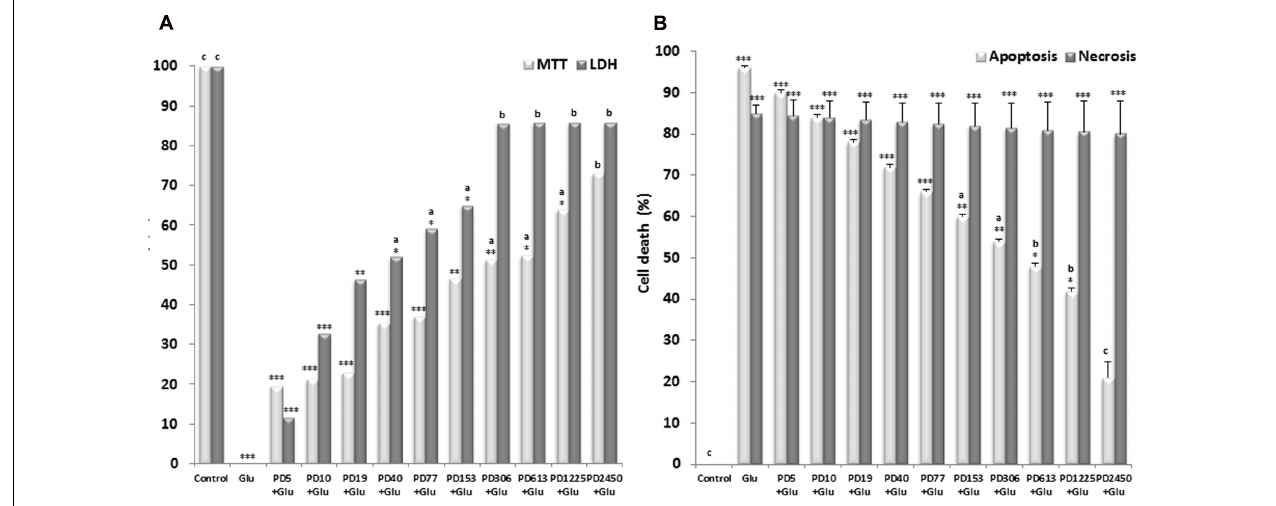
FIGURE 5 | Effects of P. daemia against L -glutamate-induced neurotoxicity, apoptosis and necrosis. (A) Effects of P. daemia against L -glutamate-induced neurotoxicity. (B) Effects of P. daemia against L -glutamate-induced apoptosis and necrosis. Quantitative analysis of the histograms expressed as the percentage of cell viability or cell death by apoptosis and necrosis. Data are mean ± SEM. Newman Keul’s multiple comparisons post hoc test, with Mann–Whitney U test correction : (i) vs. control: ∗ p < 0.05, ∗∗ p < 0.01, ∗∗∗ p < 0.001; (ii) vs. L -glutamate : a p < 0.05, b p < 0.01, c p < 0.001. PD, Pergularia daemia (5, 10, 19, 40, 77, 153, 306, 615, 1225, 2450 µ g/ml); MTT, 3-(4,5-dimethylthiazol-2-yl)-2,5-diphenyl tetrazolium bromide; LDH, lactate dehydrogenase; Glu, L -glutamate (10 mM); PD, Pergularia daemia (5, 10, 19, 40, 77, 153, 306, 615, 1225, 2450 µ